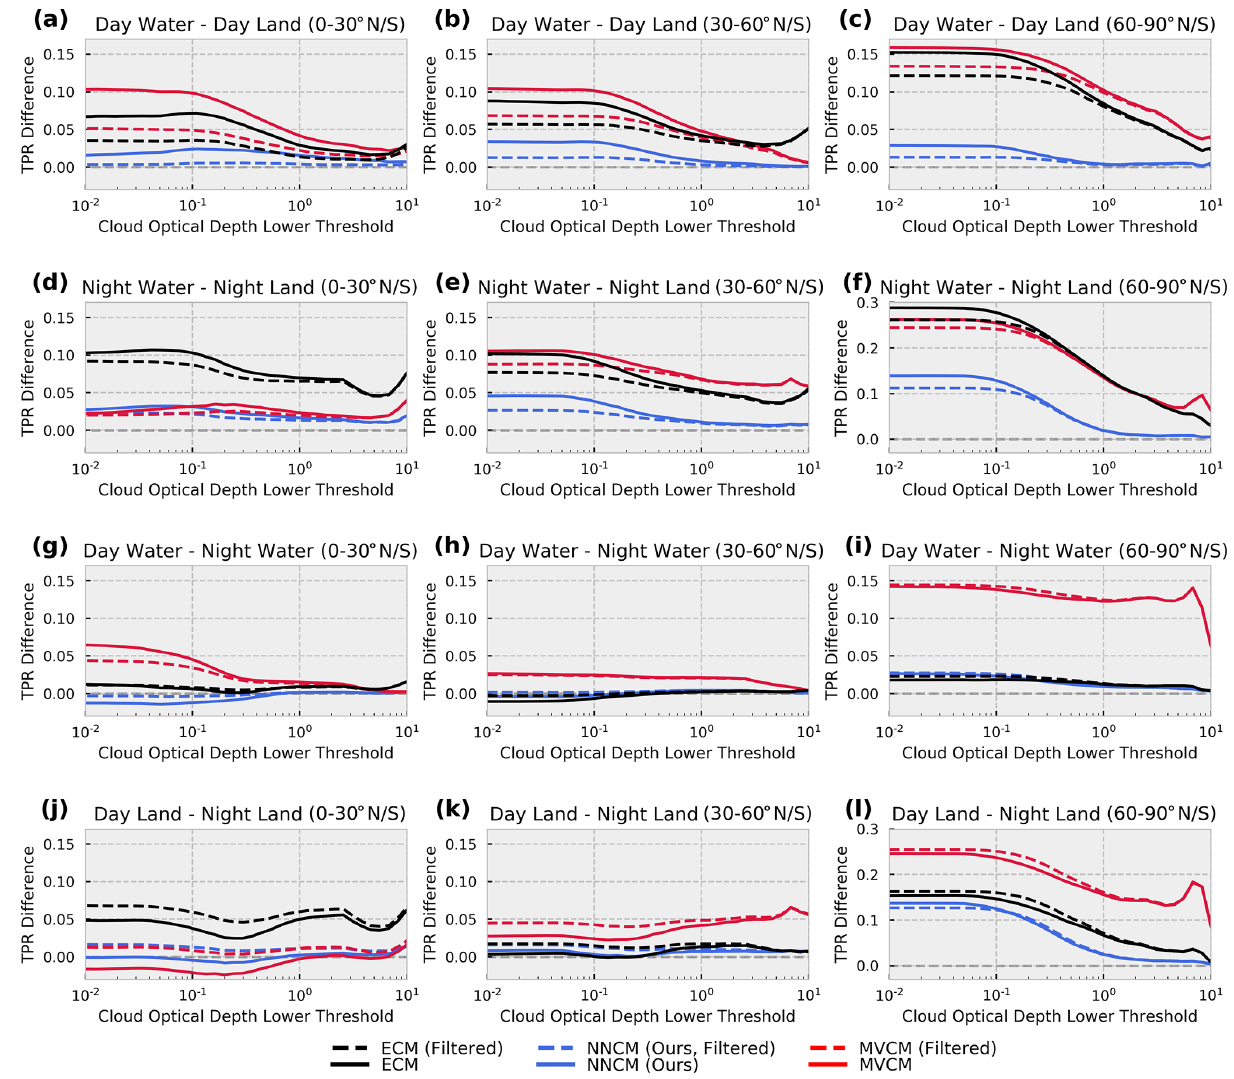
Figure 12. TPR differences over combinations of land–water and day–night conditions. The specific TPR difference and latitude are labeled at the top of each subplot. Note that the y -axis limits are different for (f) and (l)